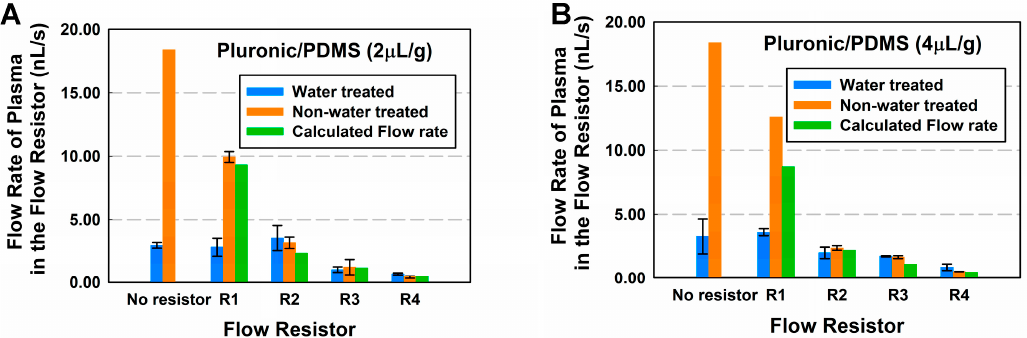
Figure 4. The flow rates of plasma in the flow resistor made of ( A ) Pluronic/PDMS (2 μ L/g); ( B ) Pluronic/PDMS (4 μ L/g). Table 5. Flow rates of plasma in the flow resistors.